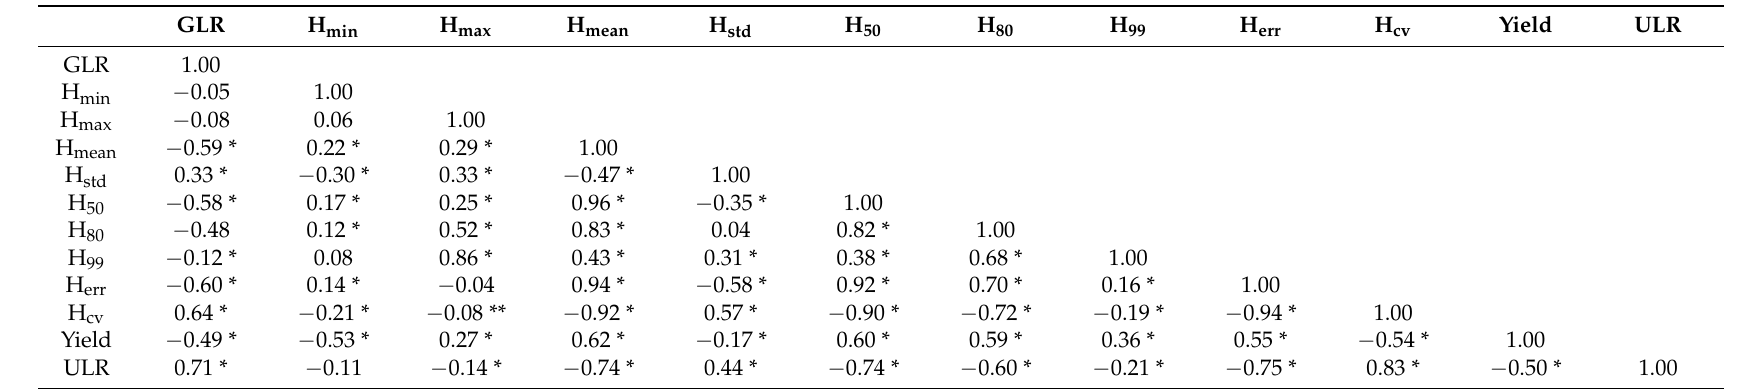
Table 4. Correlation matrix displaying the correlation coefficients among ground-measured lodging rate, UAS-estimated lodging rate, canopy structural complexity metrics and yield. This table is for the lower portion of the field trial as shown in Figure 1 due to its availability of the yield and ground-based lodging data. Correlations to the yield were calculated on a per-plot basis, while correlations to other variables were calculated based on individual